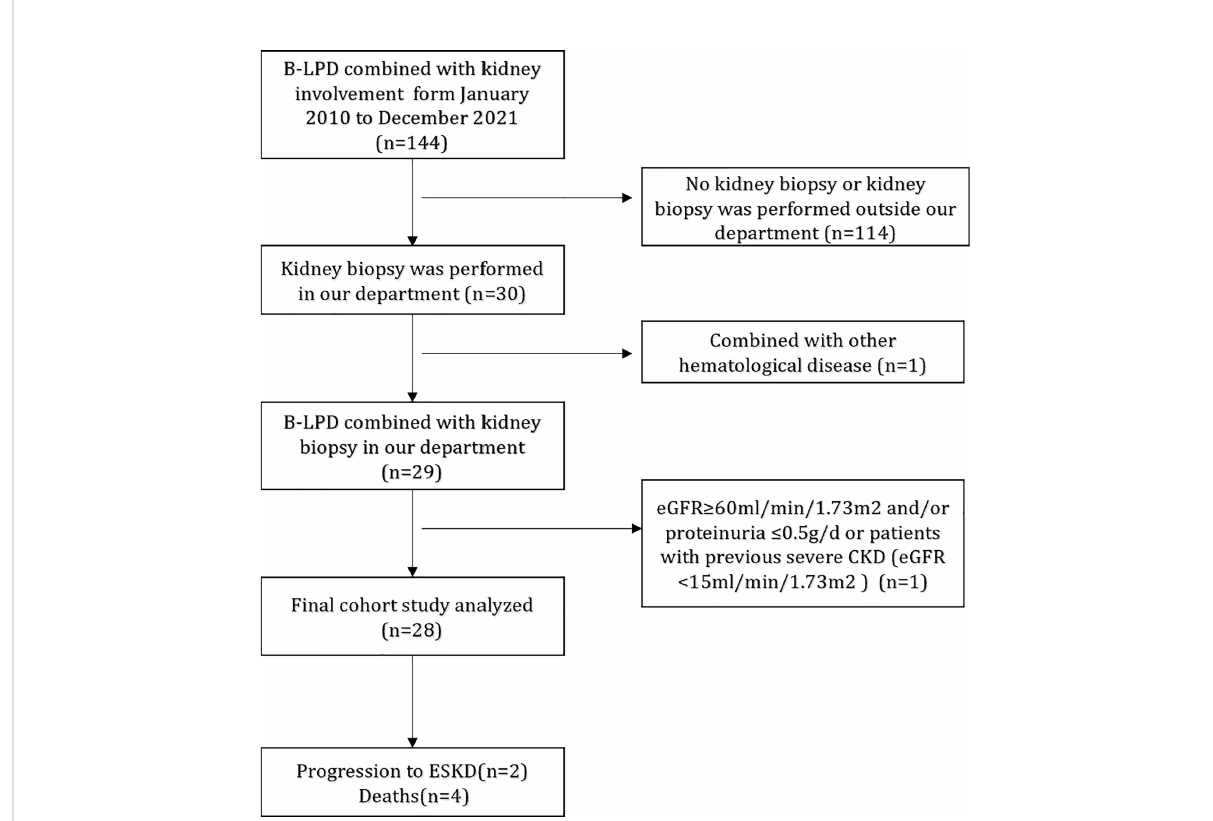
FIGURE 1 Flowchart of study participants. B-LPD, B-cell lymphoproliferative disorders; eGFR, estimated glomerular fi ltration rate; CKD, chronic kidney disease; ESRD, end-stage renal